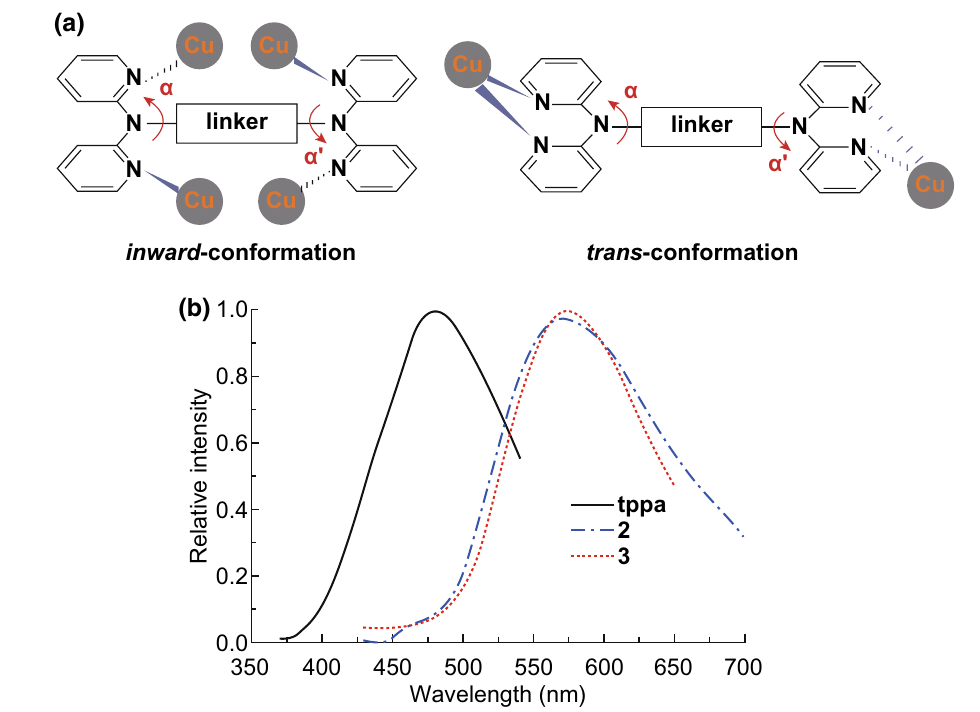
Fig. 8 a Inward - and trans -conformations of [Cu 6 (tppa)(μ 3 -Br) 6 ] n and [Cu 2 (tppa)(μ-CN) 2 ] n ,. b Emission spectra of free tppa ligand, [Cu 6 (tppa) (μ 3 -Br) 6 ] n (2) and [Cu 2 (tppa)(μ-CN) 2 ] n (3). Reprinted with permission from Ref. [40]. Copyright 2012, Royal Society of